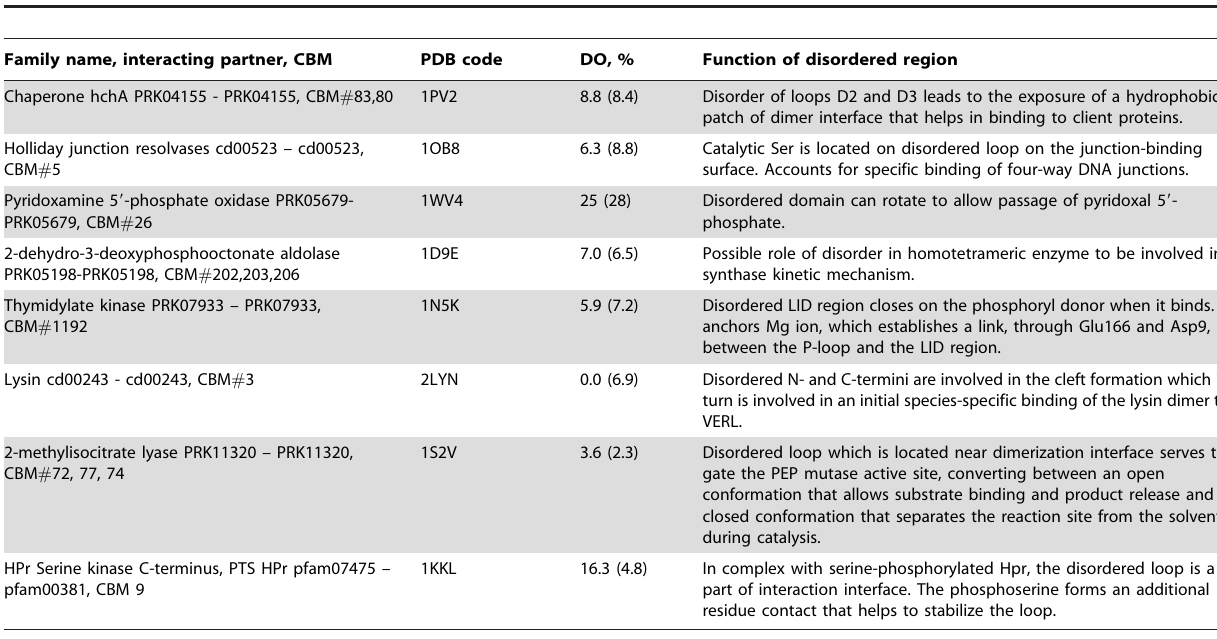
Figure 3. Histogram of fraction disorder in protein complexes (‘‘test588’’). Fraction disorder is calculated for aligned (black) and footprint regions (grey). The ‘‘footprint region’’ extends from the first to the last residue in the alignment mapping CDD family to a given chain. ‘‘Aligned regions’’ are more extensive than footprint regions and cover footprint regions plus C and N- terminal protein regions. doi:10.1371/journal.pcbi.1000316.g003 Table 1. Examples of protein complexes with